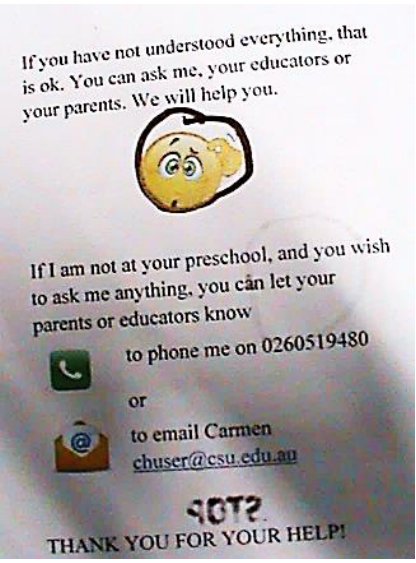
Figure 1: Louis's provisional consent .